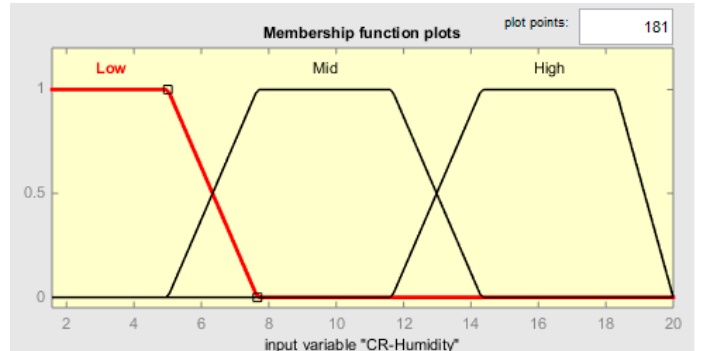
Figure 9. CR-Temp MF plot.